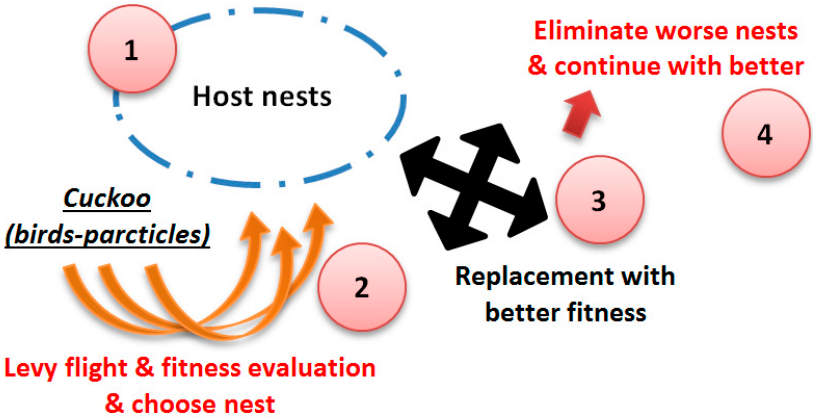
Figure 3. General solution flow of the cuckoo search algorithm.